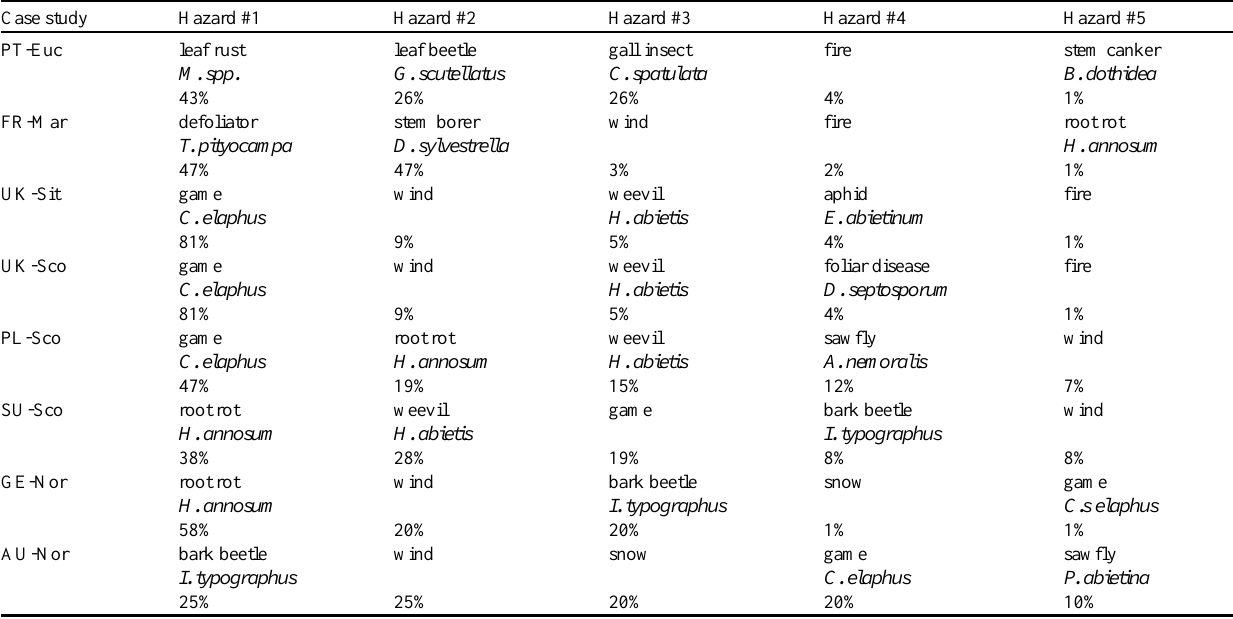
Table 3 . Name and relative likelihood (weight) of the five most frequent hazards in the eight regional case studies The relative likelihood of hazards was estimated as the percentage of trees affected by each of the five hazards at the stand level, according to the patterns of occurrence observed during the last 30–50 years. Then percentages were transformed in relative proportions (sum =